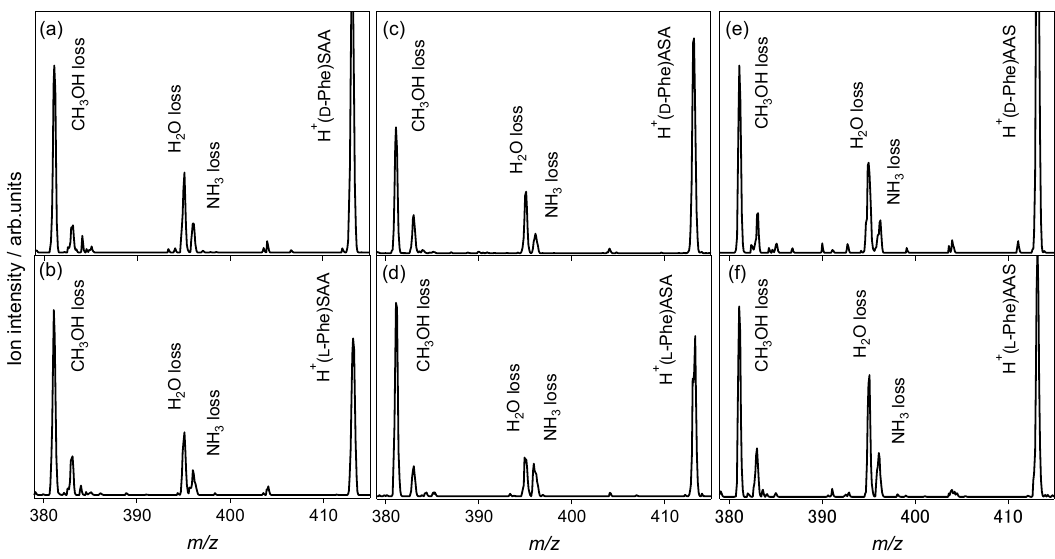
Figure 3. Collision-activated dissociation spectra of protonated noncovalent complexes of phenylalanine with L -serine-containing tripeptides: ( a ) H + ( D -Phe)SAA, ( b ) H + ( L -Phe)SAA, ( c ) H + ( D -Phe)ASA, ( d ) H + ( L -Phe)ASA, ( e ) H + ( D -Phe)AAS, and ( f ) H + ( L -Phe)AAS ( m / z 413).